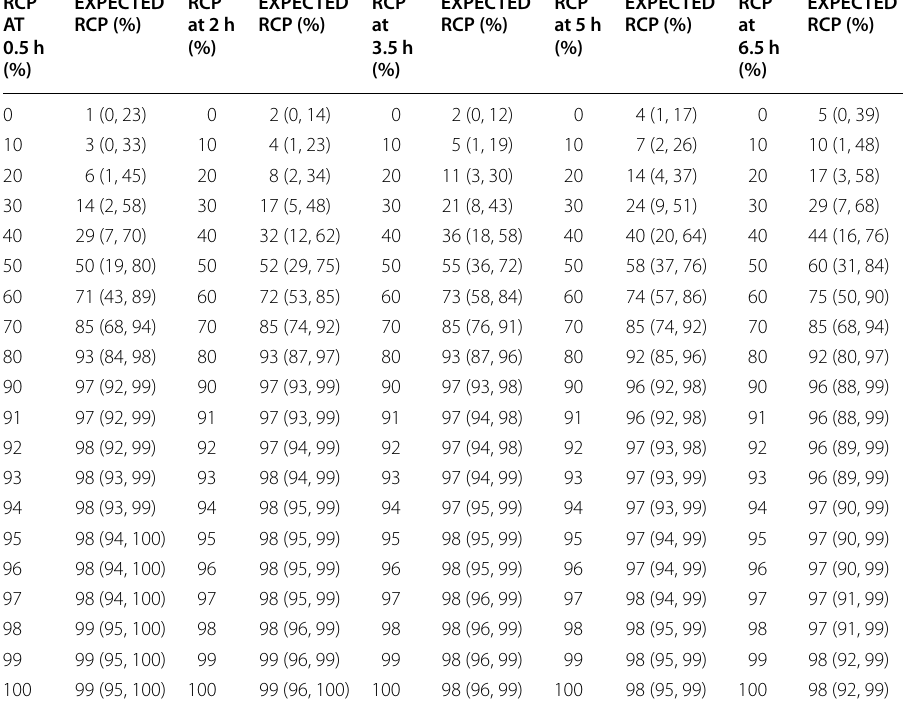
Data were generated using unpurified reactions and are expressed as expected value with prediction interval